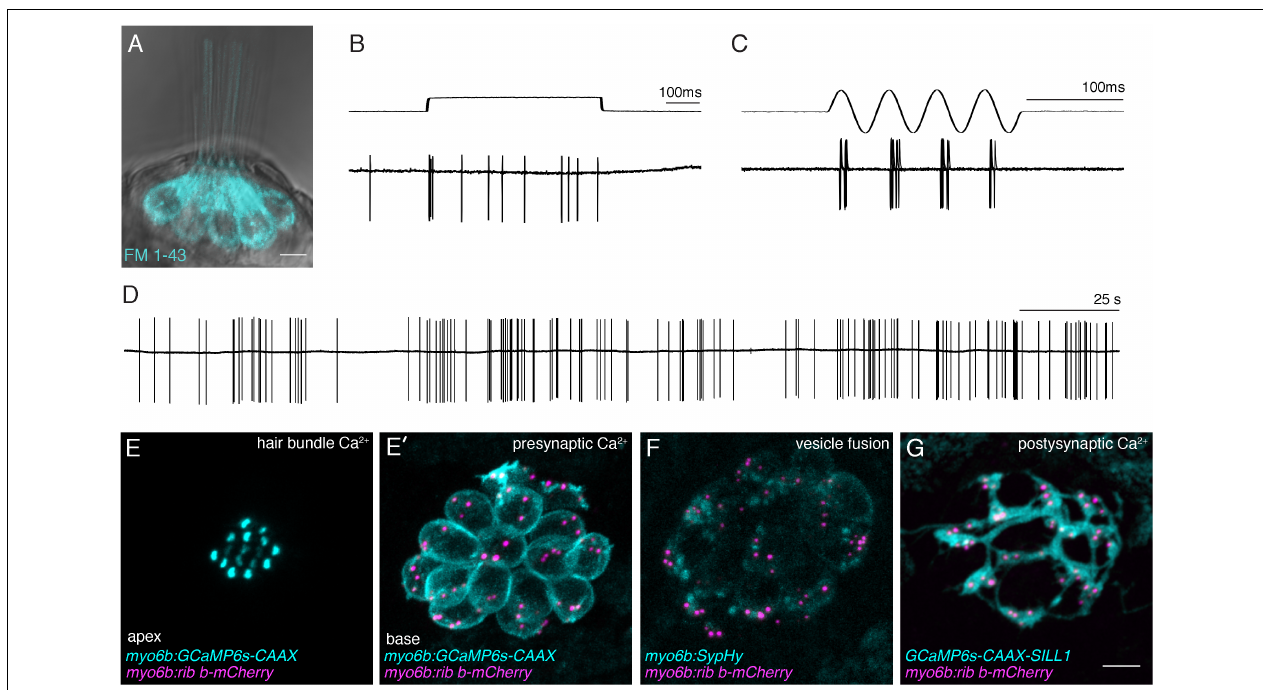
FIGURE 3 | Functional analysis of hair-cell synapses in the zebrafish lateral line. (A) In the lateral line, rapid uptake of the vital dye FM 1-43 (cyan), shown in this example, indicates mechanotransduction is intact in these hair cells. (B–D) Extracellular recordings from the afferent cell bodies in the posterior lateral-line ganglia can be used as a read-out of synapse function. During these afferent recordings, evoked spikes can be detected when innervated hair cells are stimulated along their axis of sensitivity (B,C) . Step stimuli ( B , anterior step shown) are useful to quantify spike number and the timing of the first spike. Sine stimuli ( C , anterior- posterior sine stimulus shown) are useful to quantify the precision of spike timing within the waveform. Note that each afferent only responds to one direction of stimuli (for example the anterior but not posterior phase of the sine wave in C ). Even in the absence of stimuli there is spontaneous spiking in that can be used as a read-out of synaptic function (D) . (E,E’) A transgenic line expressing a membrane-localized calcium indicator GCaMP6s (cyan) can be used to detect mechanotransduction-dependent calcium influx in apical hair bundles (E) and calcium influx at synaptic ribbons (E’) when apical and basal planes are imaged respectively. (F) Transgenic fish expressing SypHy, an indicator of vesicle fusion can be used to detect presynaptic vesicle fusion at hair-cell synapses. (G) GCaMP6s can also be used to detect postsynaptic calcium activities in the afferent process beneath hair cells. All of the transgenic approaches outlined in (E–G) can be used in combination with a transgenic line that marks synaptic ribbons via a Ribeye b-mCherry fusion protein. The scale bar in (A,G) = 5 µ